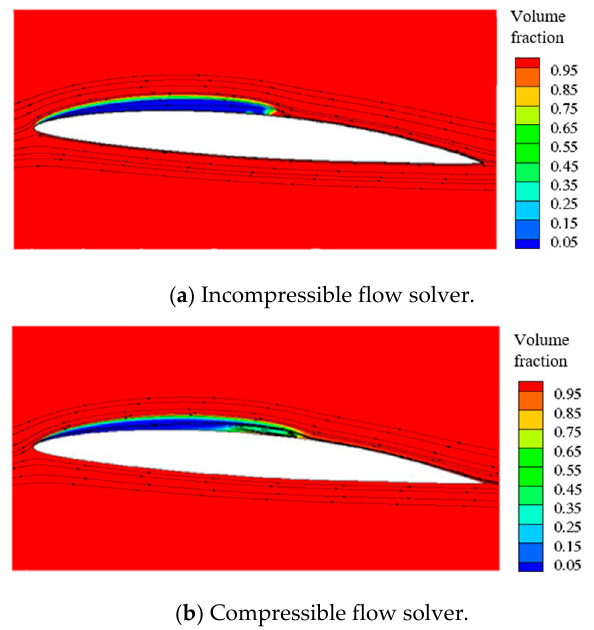
Figure 4. Cavitating flow around a modified NACA66 hydrofoil at 𝜎 = 0.84 .